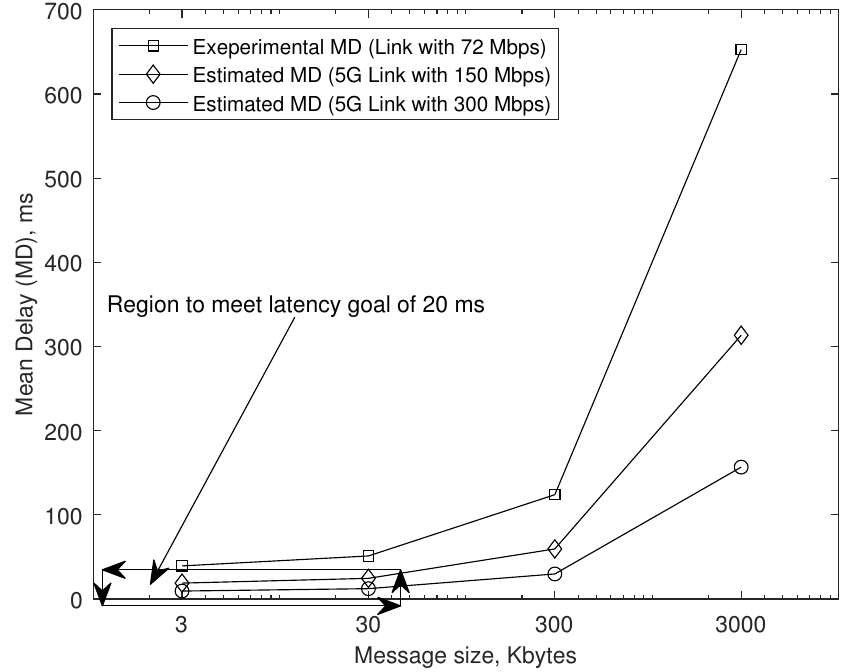
Figure 10. Latency comparisons between centralized control and SGS scenarios.